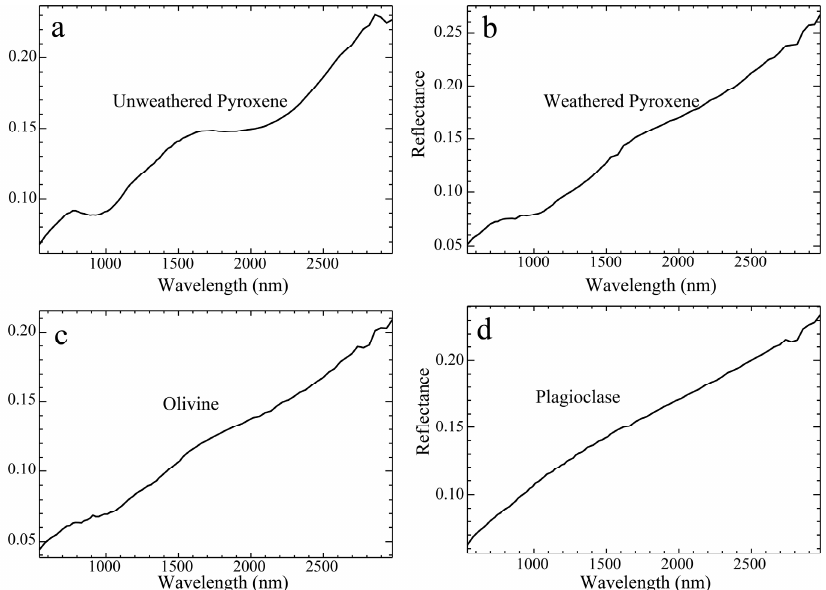
Figure 13. The spectral reflectance curve of the materials in Nectaris Basin: ( a ) unweathered pyroxene-rich basalt, ( b ) weathered pyroxene-rich materials at the Rosse crater wall, ( c ) olivine-rich materials in the Beaumont L crater wall, and ( d ) feldspathic materials on the non-mare region. Similar to Nectaris Basin, Mare Orientale and the surrounding highlands area is clearly distinguishable on the IBD map of the Orientale Basin region. At the wall of the Il’in crater (e.g., point a in Figure 12c), the M3 spectral reflectance curve shows strong absorption at both 1000 nm and 2250 nm (Figure 14a), which indicates that there are some fresh pyroxene-rich materials in the crater. The basalts in Mare Orientale and Lacus Veris are yellow in color (e.g., point b in Figure 12c), displaying relatively weak absorption features at both 1000 nm and 2250 nm (Figure 14b). The features indicate that the basalts contain weathered pyroxene. In the northwestern rim of the Kopff E crater, there is a small and fresh crater (point c in Figure 12c). The M3 spectrum of point c displays an absorption band at 1 μ m but no absorption band at 2000 nm (Figure 14c), which indicates that there possibly are olivine-rich materials here. The surrounding highlands in the composite spectral parameter map are blue-purple in color (e.g., point d in Figure 12c), which suggests that the composition of the highland plagioclase dominates (Figure 14d).